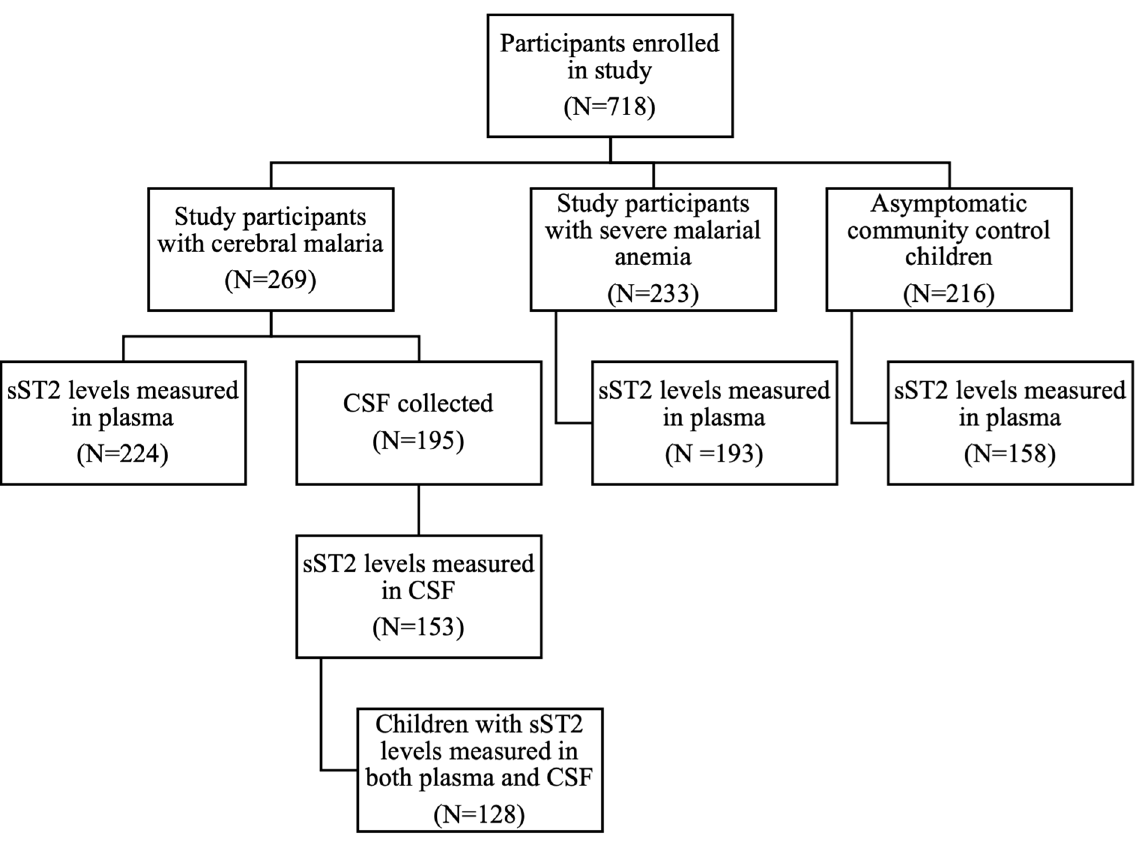
Figure 1. Diagram of Study Participants.